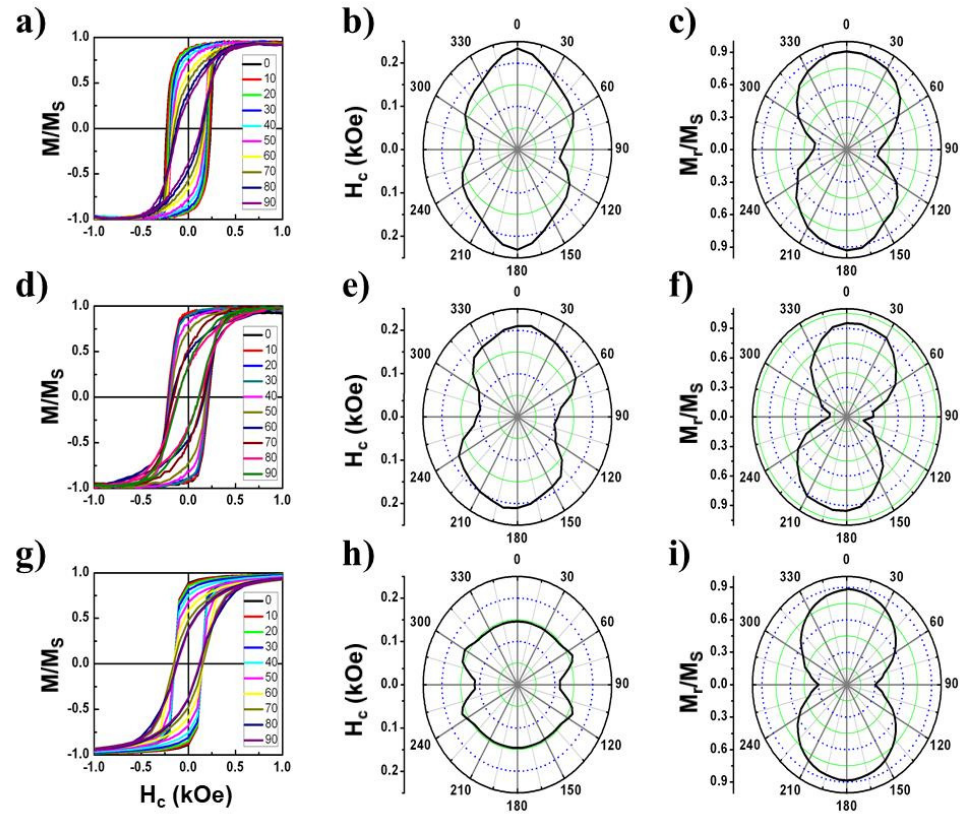
Figure 7. In-plane azimuthal VSM hysteresis loops, M/Ms, of ordered Co double-nanostripes with 20 ( a ), 50 ( d ) and 100 nm ( g ) Co thick. The corresponding angular dependence of coercivity, Hc, and reduced remanence, Mr/Ms, are given in ( b , e , h ) and ( c , f , i ), respectively. The reference 0 ◦ corresponds to parallel alignment of the applied field with the nanostripe main axis.